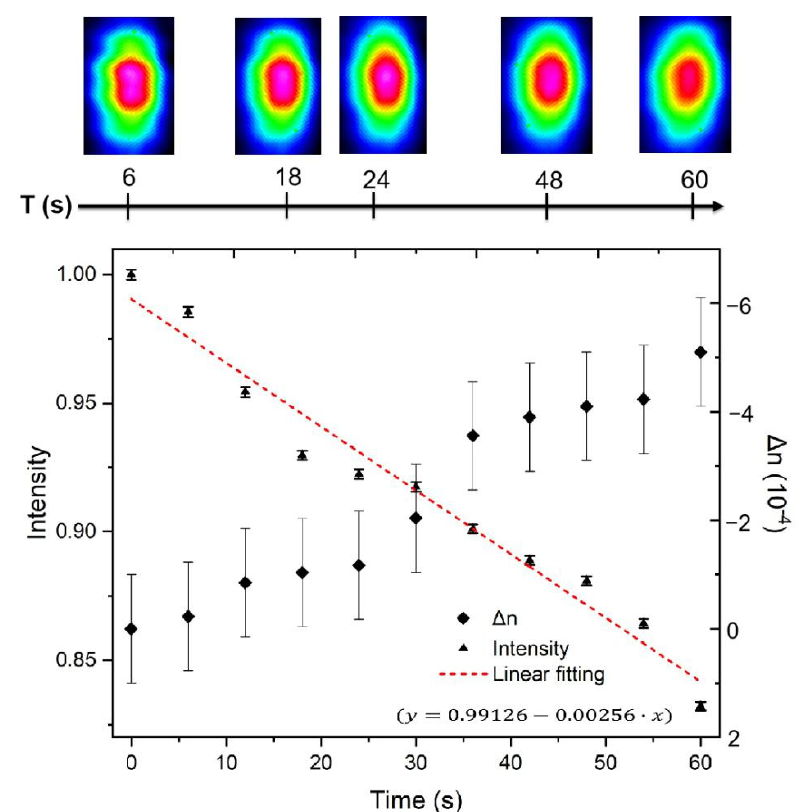
Figure 8. Evolution of the peak intensity of the near-field distribution and the change of refractive index contrast during the first minute after ethanol deposition on the PG surface. The inserted images are the near-field distributions at 6, 18, 24, 48, and 60 s.